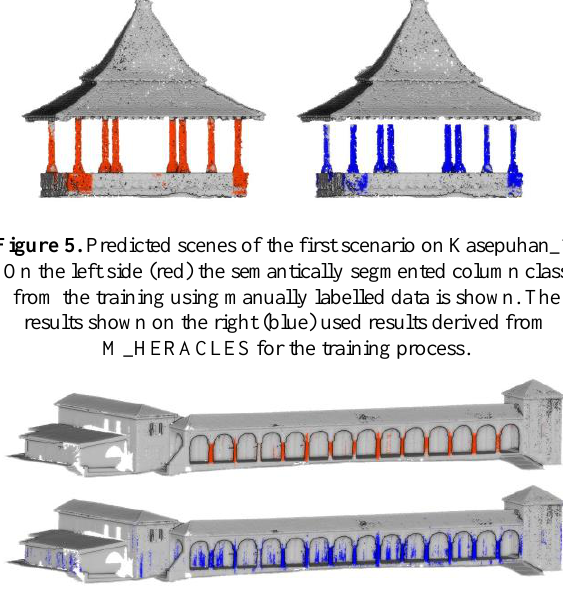
Figure 6. Predicted scenes for the second scenario. On the top side the result (red) from the manually labelled scenes used as training; on the bottom results (blue) from training using data derived from M_HERACLES.